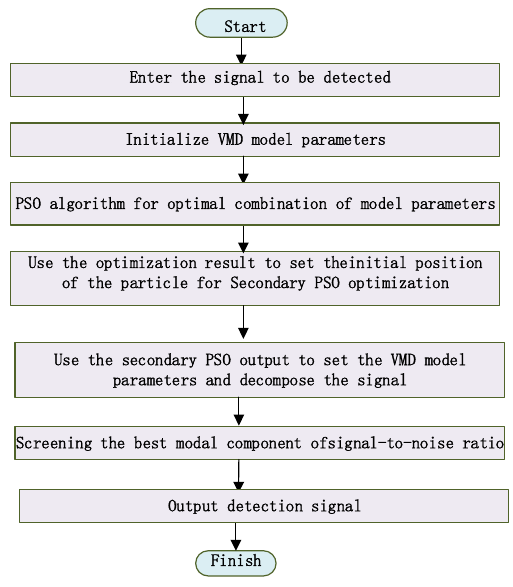
Figure 2. PSO-VMD detection 1/ f noise flow chart.